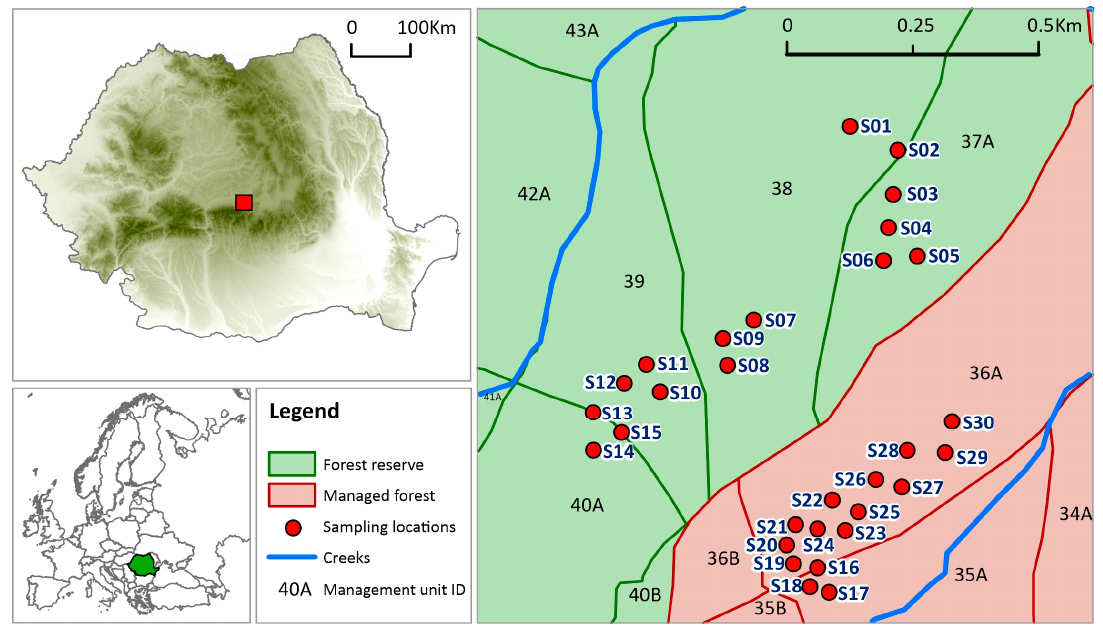
Figure 1. The map of beetle sampling locations in the Ș inca Old-Growth Forest.